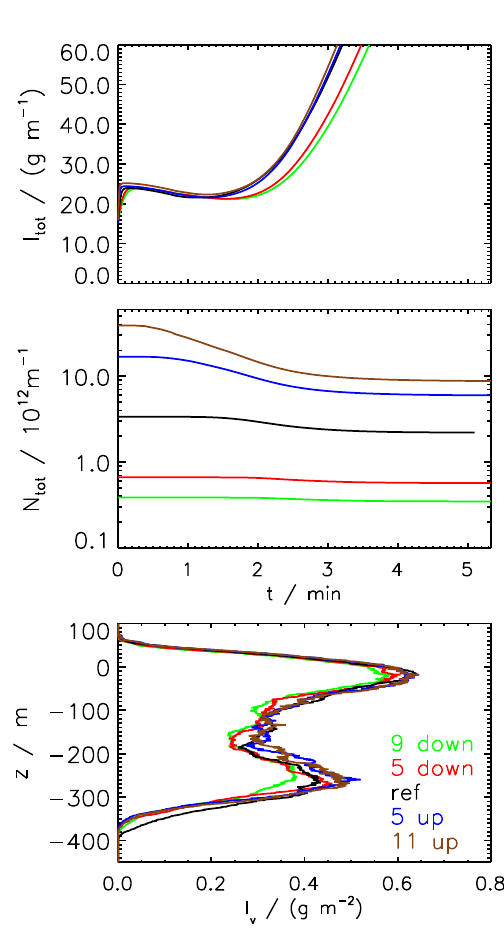
Figure 4. Variation of EI iceno for a B777/A350-type aircraft, RH i = 120%, T = 217K and N BV = 0 . 0115s − 1 . The reference simula- tion (ref) uses EI iceno, ref = 2 . 8 × 10 14 kg − 1 . In further simulations EI iceno is lower or higher (see legend for the scaling factors). Tem- poral evolution of total ice crystal mass (top) and number (middle) and vertical profiles of ice crystal mass after 5min (bottom).